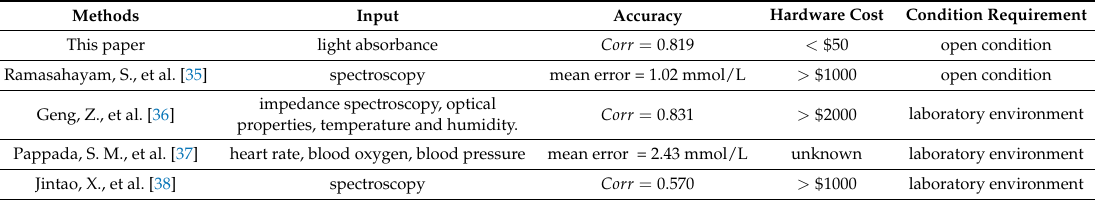
Table 5. Comparison of different Non-invasive Glucose Measurement (NGM)